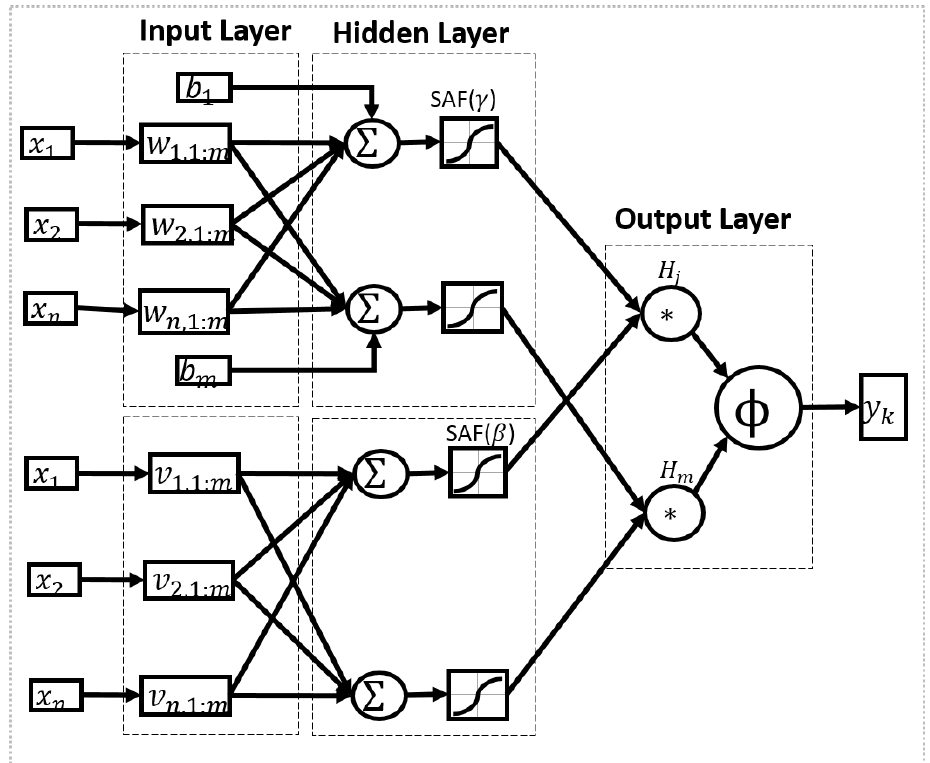
Figure 1. Parallel layer extreme learning machine architecture [28]. The weights and biases of the upper layer are assigned with Equation (4). The lower layer is weighted with Halton’s low-discrepancy sequence (LDS) and zero